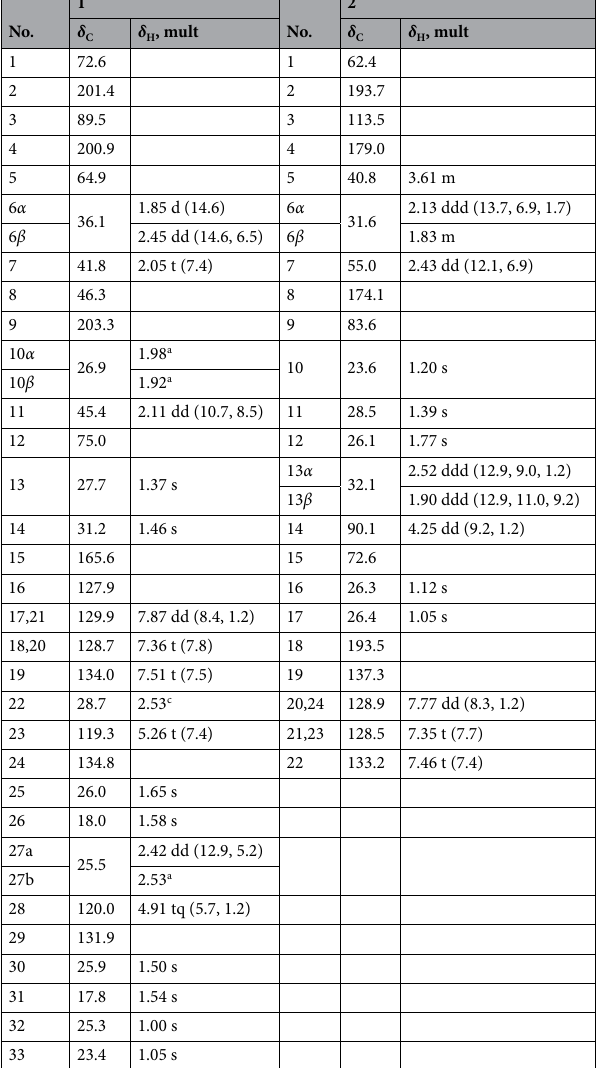
C 193.5) supported the presence of the benzoyl moiety at C-3. However, no direct HMBC correlations to C-3 were observed.